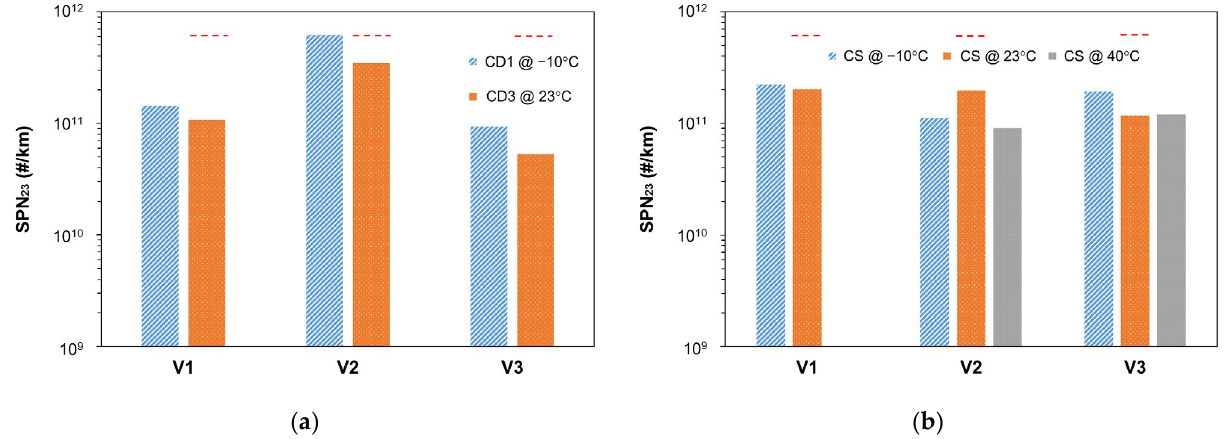
Figure 7. Solid particle number emissions (>23 nm) (SPN 23 ) of three plug-in hybrid electric vehicles (V1 to V3) over the WLTC at different temperatures and during ( a ) charge-depleting (CD) and ( b ) charge-sustaining (CS) rechargeable electric energy storage (REESS) conditions. Only CD cycles in which the internal combustion engine was ignited for the first time are plotted. The red dashed lines indicate the Euro 6 limit (6 × 10 11 #/km) for the tests in which it was applicable.